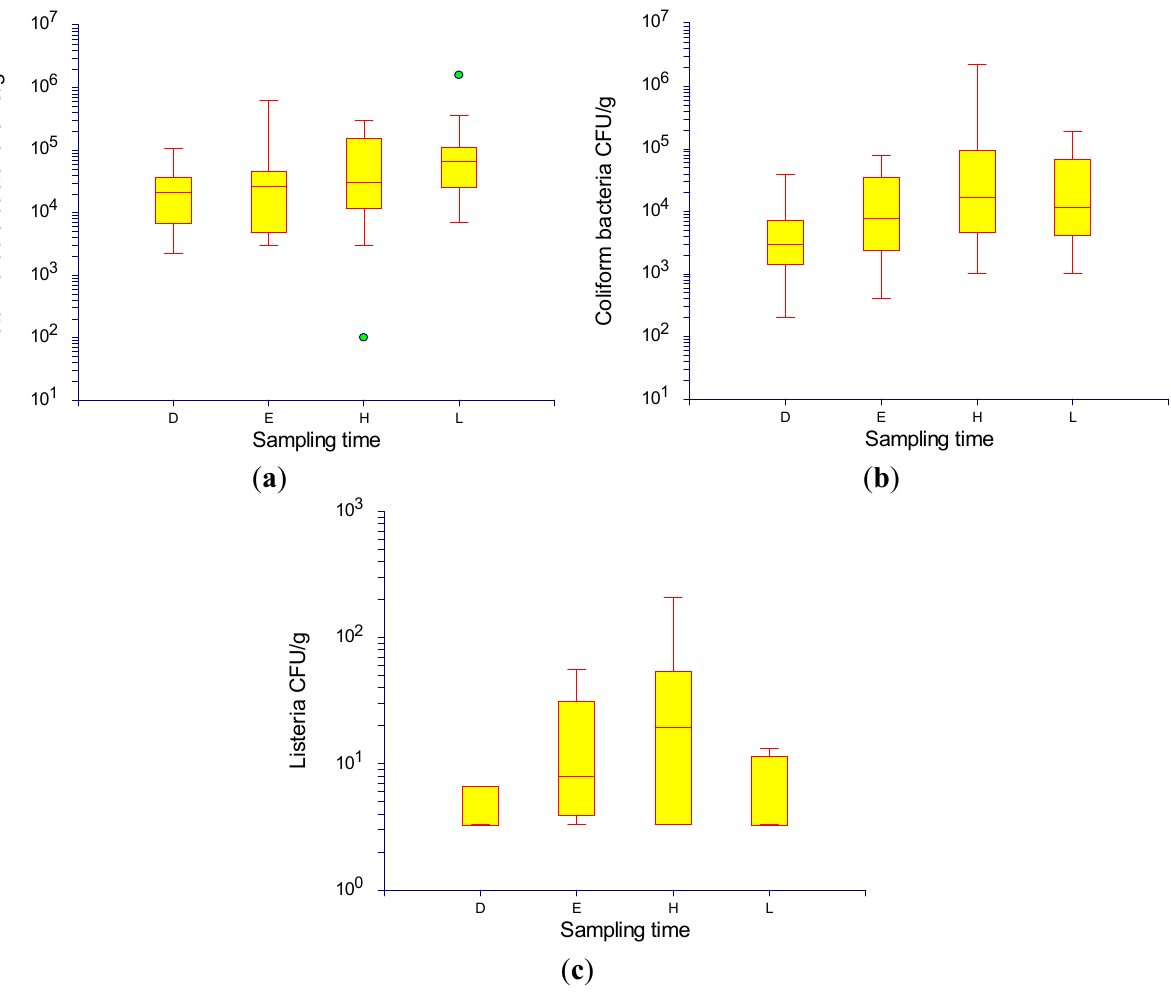
Figure 2. Bacterial plate counts from pork sampled directly following slaughter (D) and retail pork samples taken in the early morning (E), mid-morning (H), and after noon (L) carried out to estimate the burden of contamination in Kohima, Nagaland. ( a ) Total aerobic bacteria; ( b ) Enterobacteriaceae (coliform bacteria); ( c ) Listeria